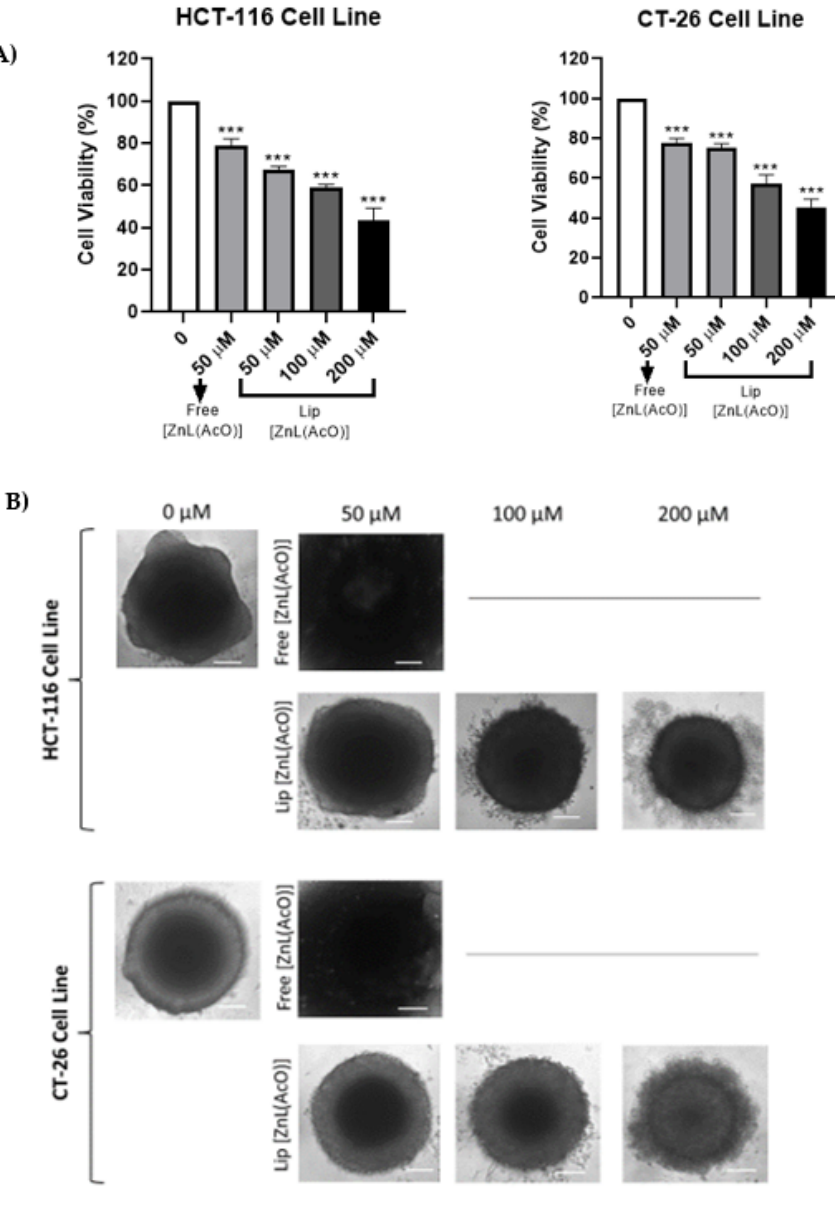
Figure 5. ( A ) Antiproliferative effect of [ZnL(AcO)] in free and liposomal forms towards HCT-116 and CT-26 spheroids. Results correspond to cellular viability expressed as mean percentage (%) ± SD of three independent experiments (*** p < 0.001 vs. control) after 120 h incubation with different concentrations (50, 100, and 200 µM) for [ZnL(AcO)] in free and liposomal forms, respectively (CellTiter-Glo ® 3D assay). ( B ) Representative microscopic images of spheroids 120 h after incubation with the respective formulations. Scale bar = 100 µm.